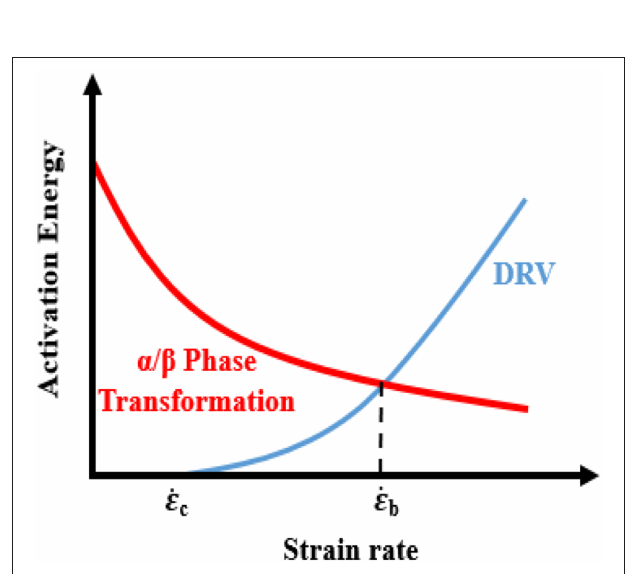
FIGURE 8 | Volume fraction of α phase of hot deformation at 655 ◦ C with different strain rate of 10 − 3 s − 1 , 10 − 2 s − 1 and 10 − 1 s − 1 ; and heat treatment at 655 ◦ C for the respective time.